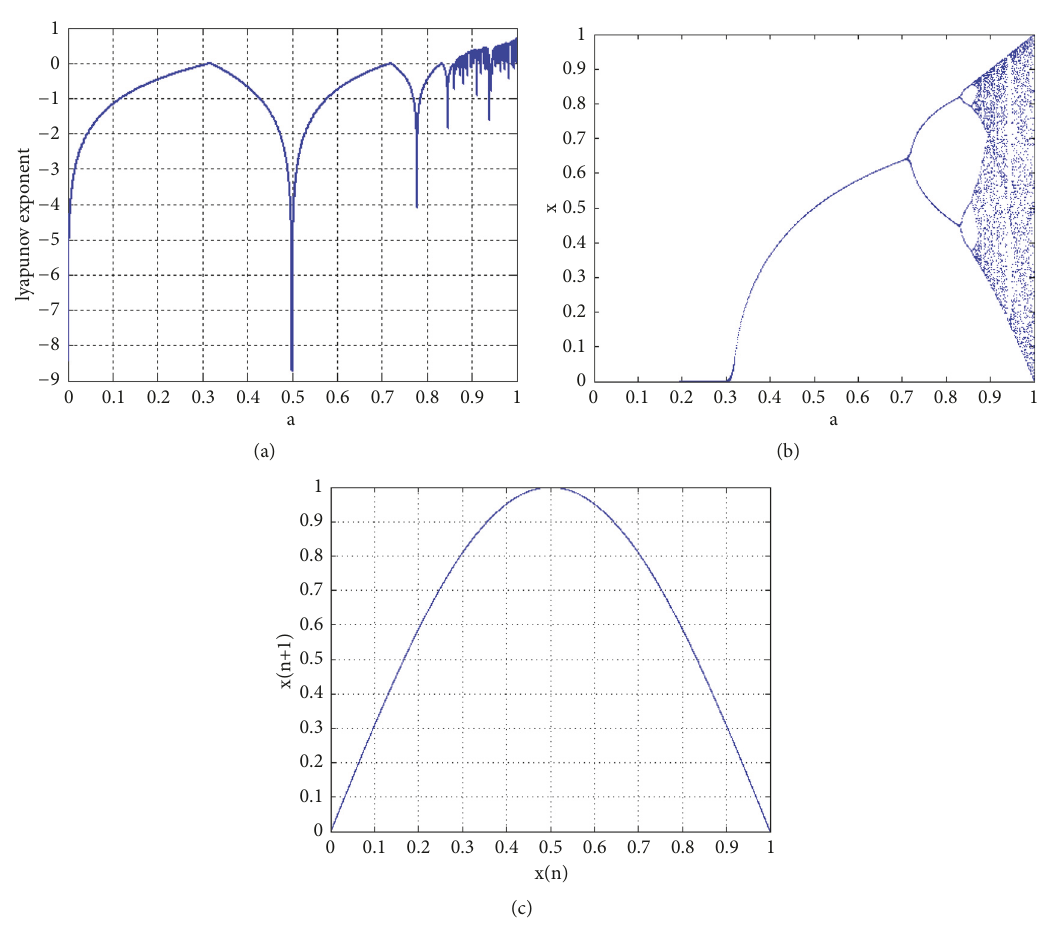
Figure 1: Dynamics of chaotic sine map: (a) Lyapunov exponent, (b) bifurcation, and (c) attractor’s phase space for 𝑎 =1.